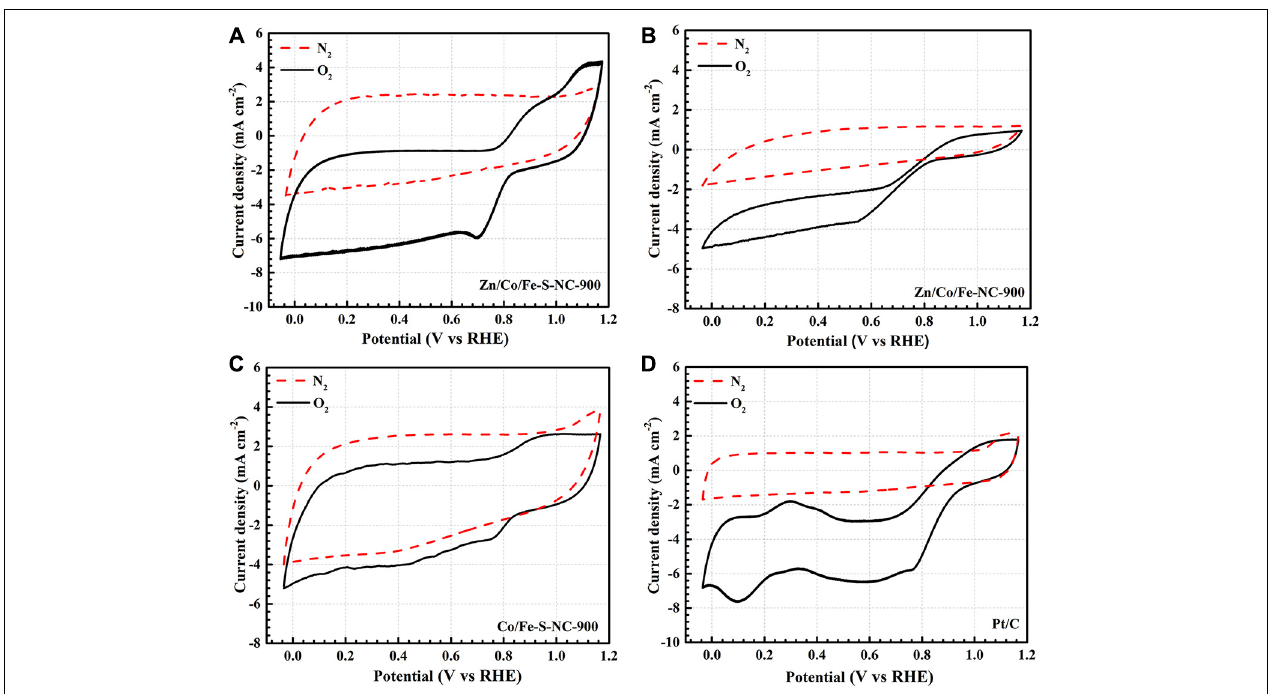
FIGURE 7 | CV curves of the obtained catalysts of (A) Zn/Co/Fe–S–NC-900, (B) Zn/Co/Fe–NC-900, (C) Co/Fe–S–NC-900, (D) Pt/C in O 2 and N 2 -saturated 0.1 M KOH solution.